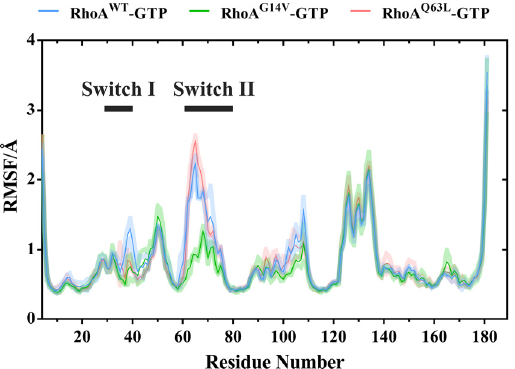
Figure 2. The RMSFs for each residue of RhoA in the complexes of RhoA WT -GTP (blue), RhoA G14V -GTP (green), and RhoA Q63L -GTP (red). All the frames were first aligned to the initial frame before calculating. Averages were obtained from the triple-independent simulation runs, and error bars correspond to the standard deviation.